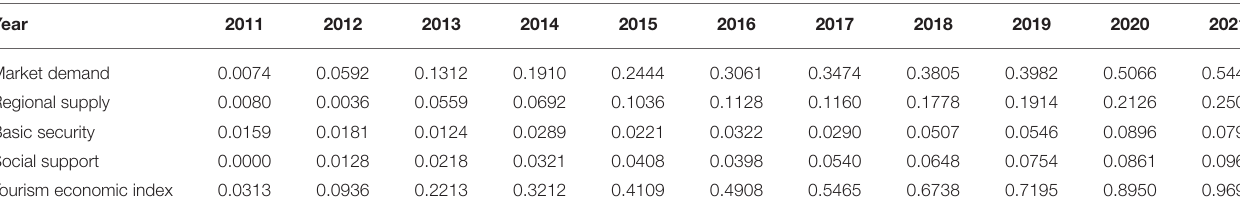
TABLE 4 | Weighted standardized indices for each dimension of Shenzhen’s tourism economy,